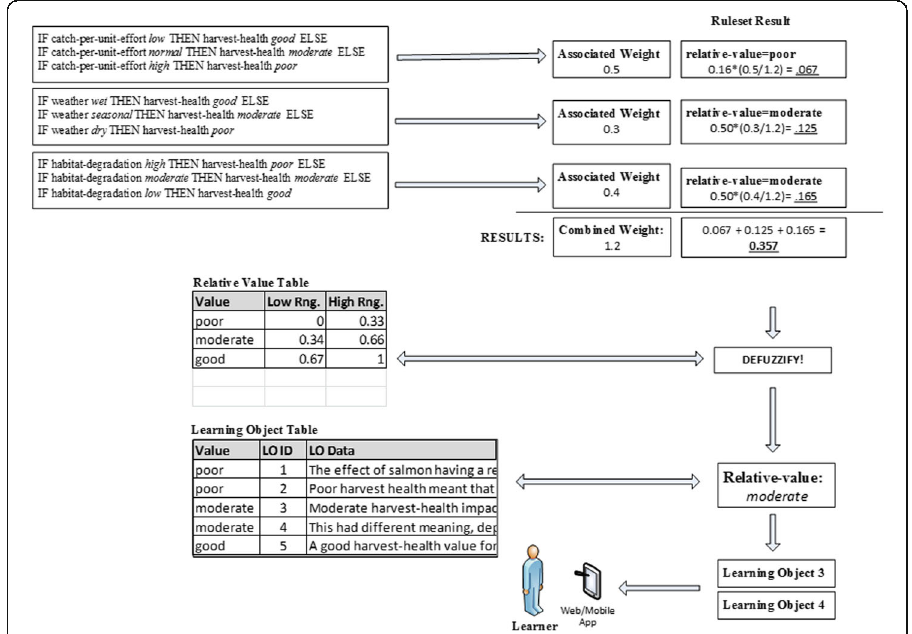
Fig. 4 Fuzzy logic aggregation